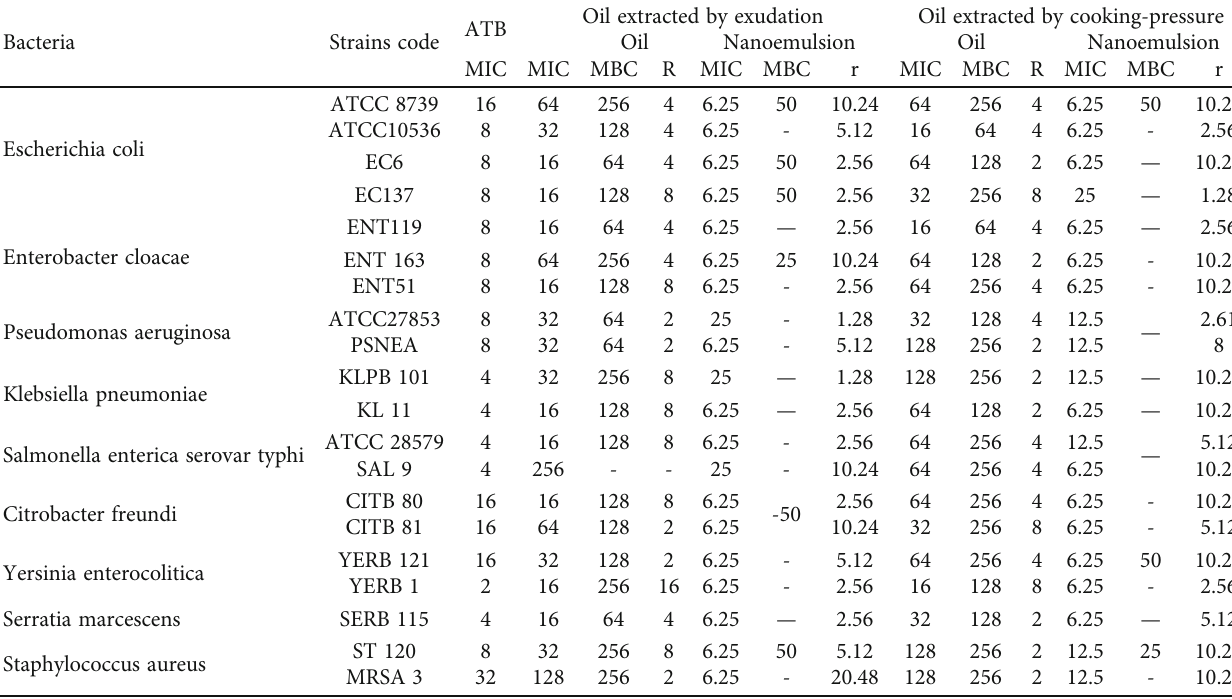
Table 3: Antibacterial activity of Fontitrygon margarita liver oils according to the extraction method (mg/ml). Bacteria Strains code